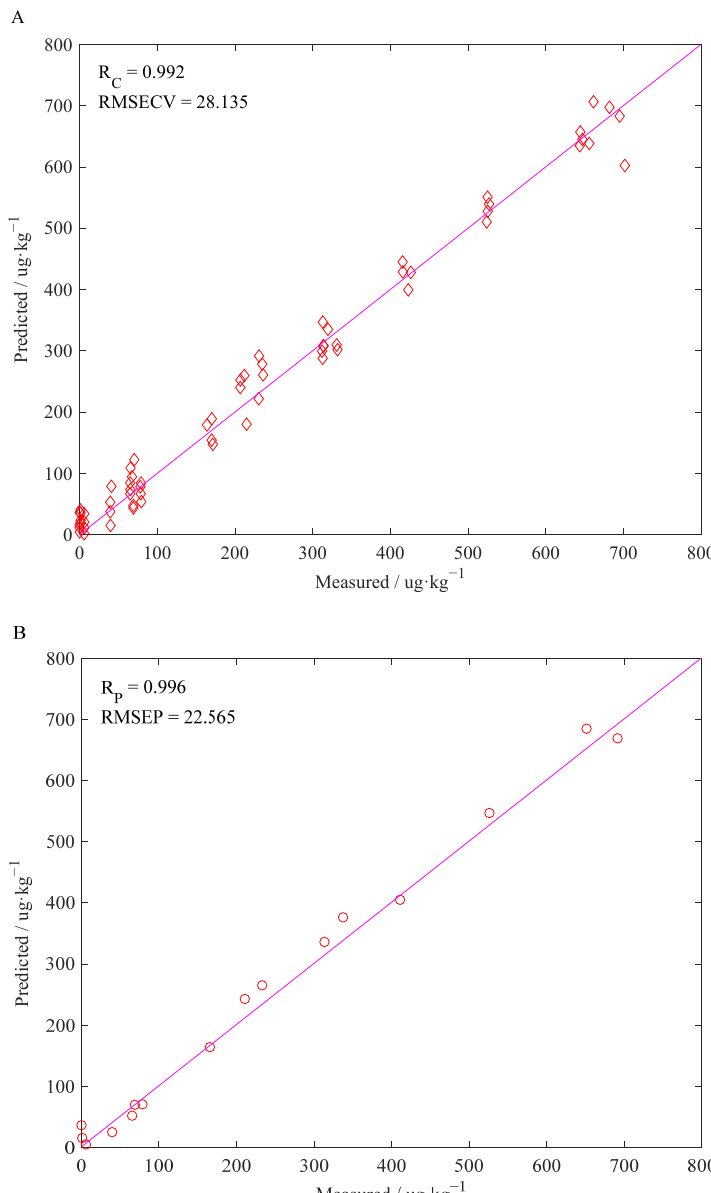
Figure 5. Comparison between the predicted value and the actual value. ( A ) Calibration set; ( B ) Prediction set.